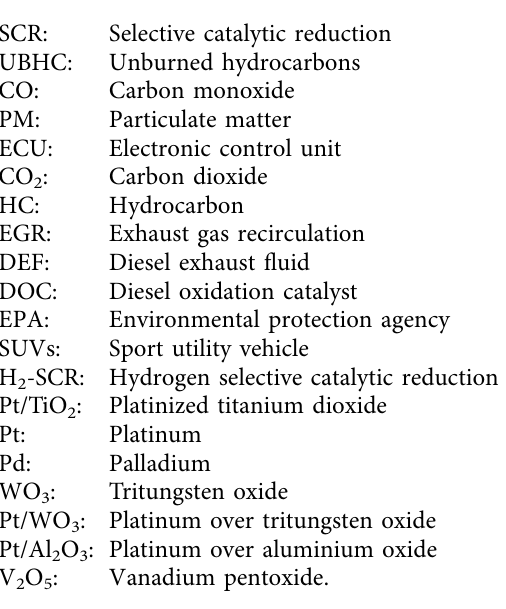
2 injection of engine speeds